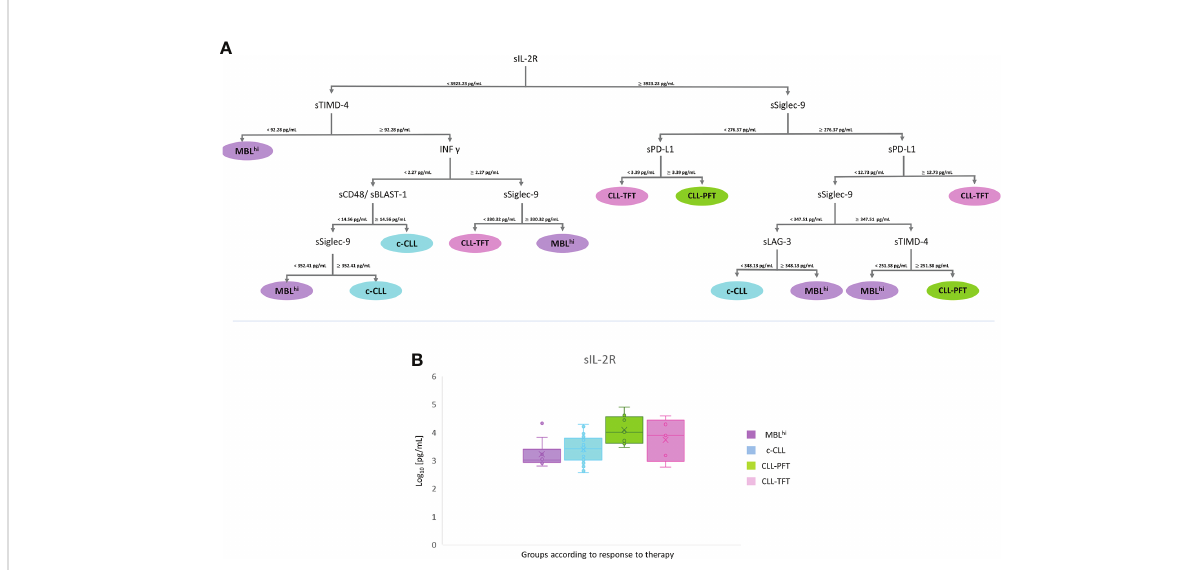
FIGURE 6 mRMR analysis according to therapy. (A) Distribution and classi fi cation from differential pro fi les of soluble receptors and immune checkpoints. (B) Boxplot sIL-2R in serum across the analyzed